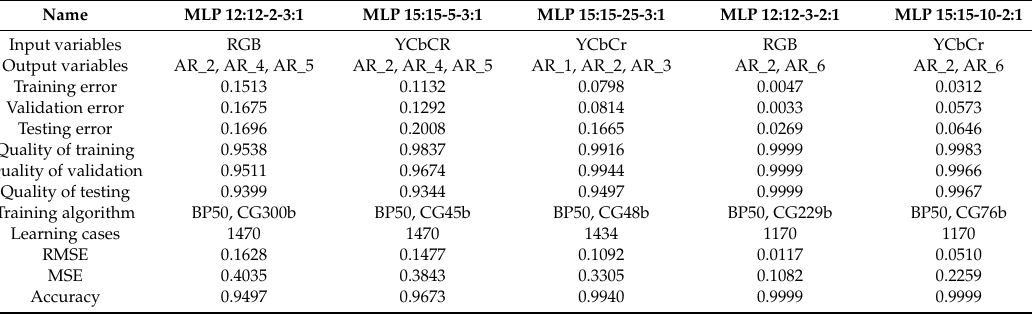
Table 4. Results of training process ANN with the selection of di ff erences in parameters influencing the drying process (inlet air temperature, rotary atomizer speed, as well as the degree of saccharification of the drying carrier